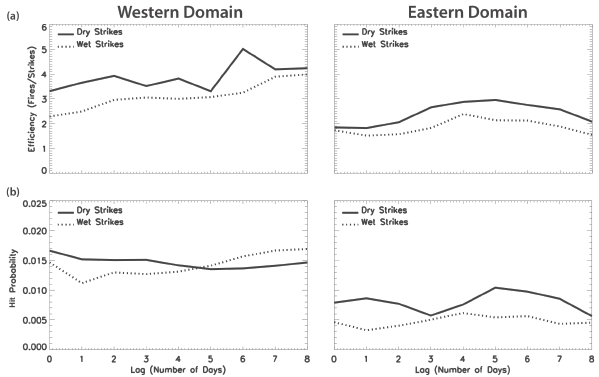
Figure 5. Fig. 5. (a) Efficiency of dry and wet lightning strikes in fire ignition for the western domain (left) and the eastern domain (right). (b) Same as (a) but for the hit probability of a fire ignition associated with a dry or wet lightning strike within a grid